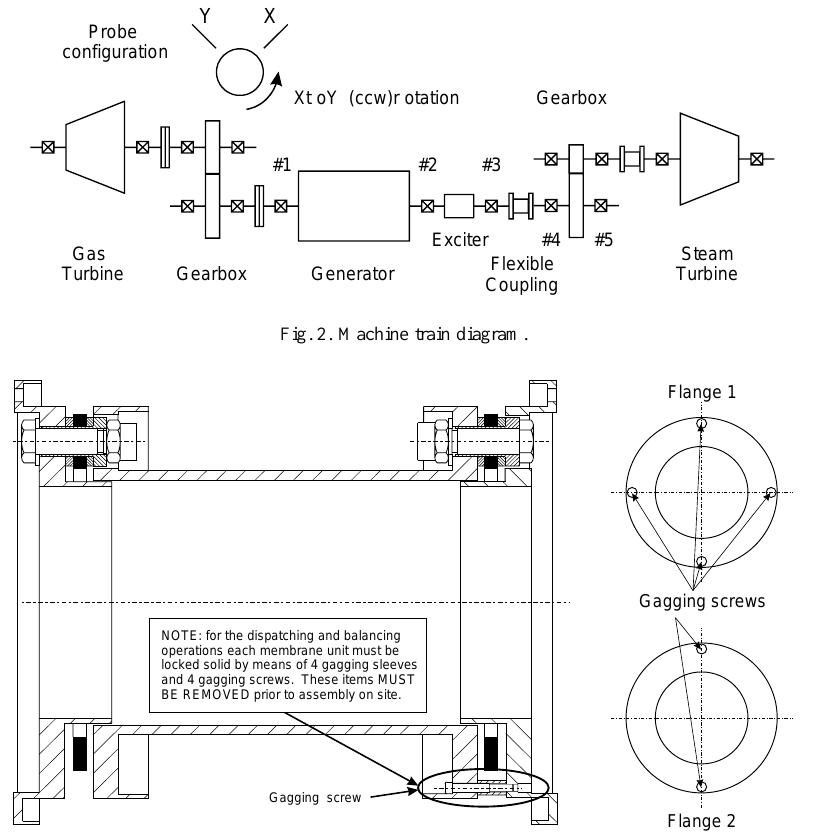
Fig. 3. Flexible coupling mounted between the generator and the slow shaft of the gearbox. Location of the gagging screws mounted on the flanges of the flexible coupling.